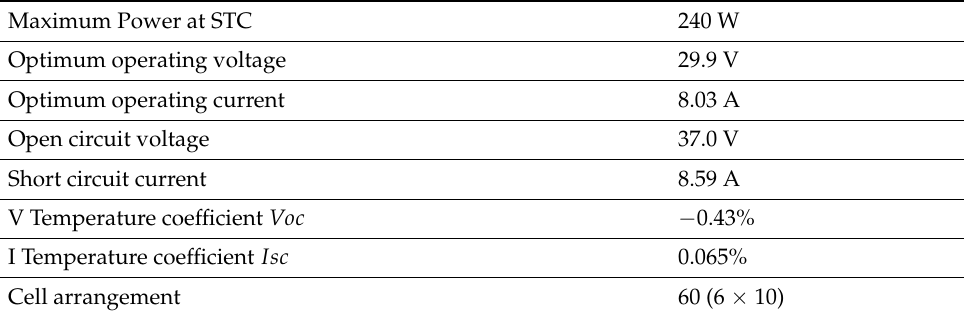
Table 2. Manufacture specification under standard test condition.